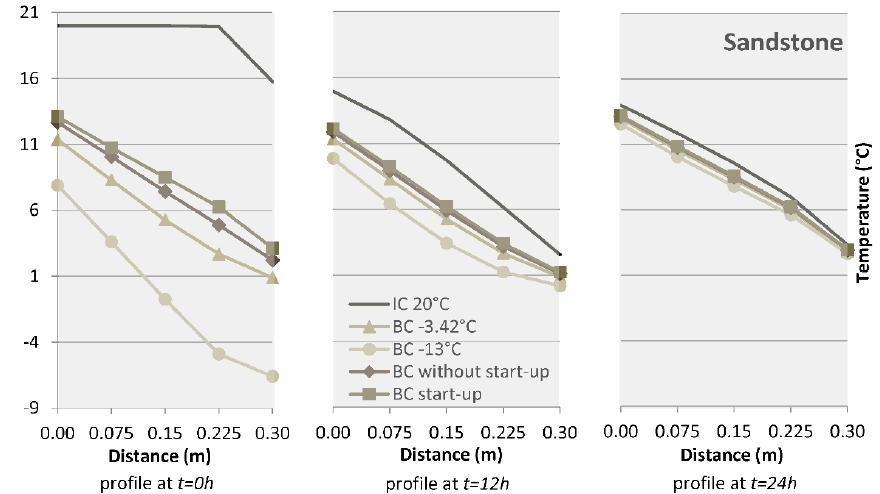
Figure 9. Temperature profile across the simple sandstone test wall at time t = 0 h, t = 12 h and t = 24 h for five cases under the initial condition. Abbreviations IC and BC refers to Section 2.4.